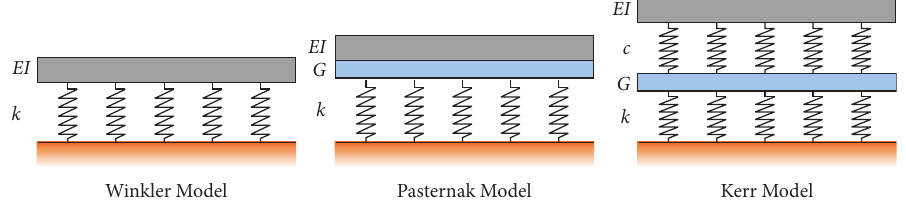
Figure 9: Three typical foundations in structure-soil interaction analysis. (a) Winkler model, (b) Pasternak model, and (c) Kerr model.